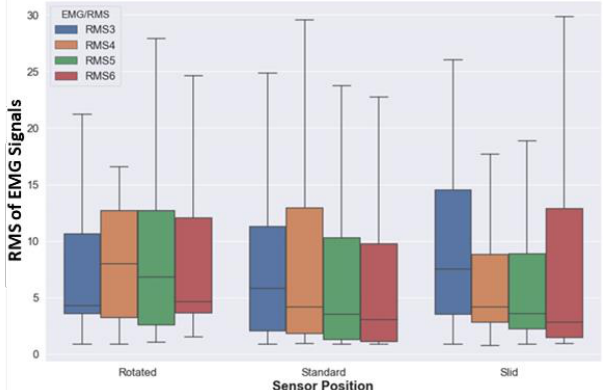
Figure 8 . Comparison of RMS values of EMG-3, 4, 5, and 6 channels for three (rotated, standard, and slid) sensor positions.